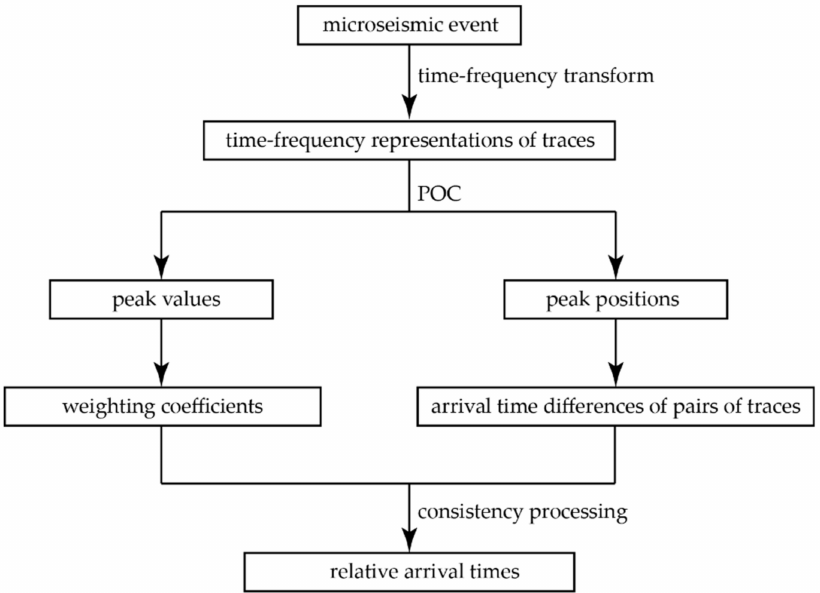
Figure 1. The flowchart of the proposed method for estimating relative arrival times. The procedure of this method starts with time-frequency transform, followed by phase-only correlation (POC) and consistency